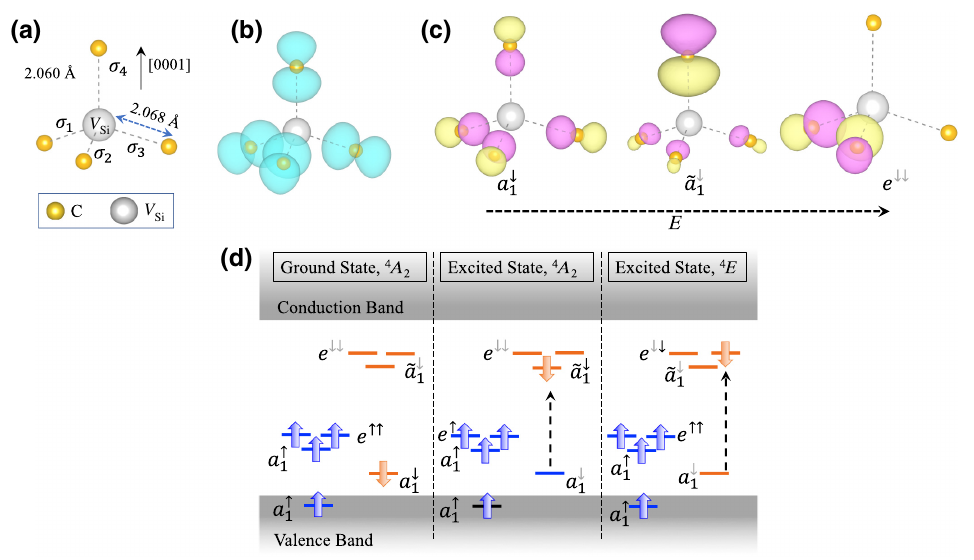
FIG. 2. A charged silicon monovacancy in bulk 2H-SiC. (a) The C 3 v -point group symmetry of V − 1 . Only the nearest-neighbor (NN) Si carbon atoms are shown for clarity. (b) The spin-density (difference in charge densities within the two spin channels) isosurface plot (in blue), showing the spatially localized nature of the defect-induced spins. (c) Charge-density plots for the optically active defect states (minority spin) that are involved in the photoexcitation process. From left to right, the lowest-energy filled singlet state ( a 1 symmetry), an unoccupied singlet, ˜ a 1 , and one of the doubly degenerate unoccupied e states. The pink (yellow) color corresponds to positive (negative) isovalues. The defect states are labeled by their respective group-theoretic representations. The black (gray) arrows in the superscripts of the labels are used to emphasize that the states are filled (empty). (d) A schematic single-particle-level diagram in the ground state and the two excited (not to scale), showing the defect states introduced by V − 1 Si